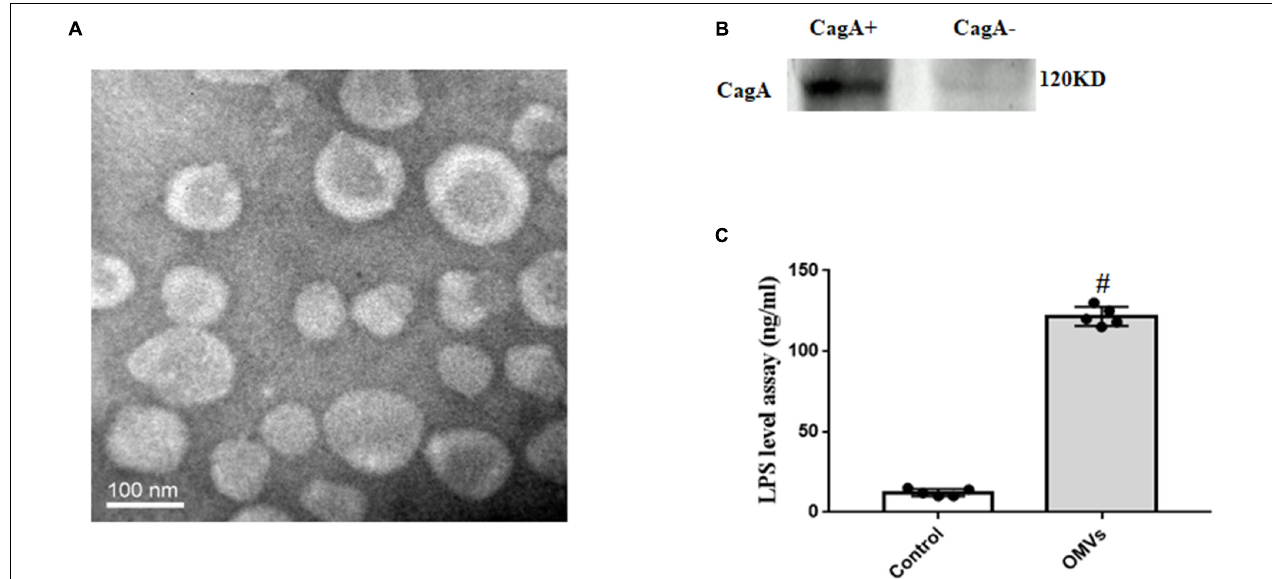
FIGURE 1 | Identification and characterization of OMVs from H. pylori . (A) Electron micrographs of OMVs from H. pylori . Isolated OMVs from H. pylori were fixed with negative staining with Na-phosphotungstate, and observed by transmission electron microscope. (B) CagA expression in H. pylori -derived OMVs (CagA + : OMVs from CagA-positive H. pylori ; CagA − : OMVs from CagA-negative H. pylori ). (C) LPS levels in H. pylori -derived OMVs and vehicle were determined by ELISA ( n = 5, # P < 0.01 vs. control).